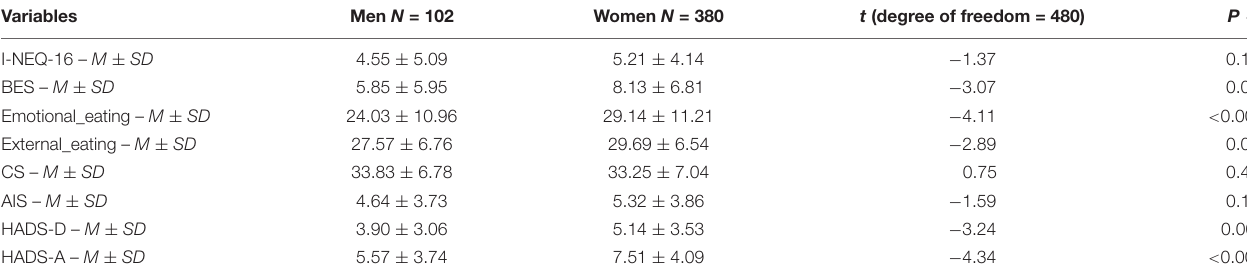
TABLE 3 | Descriptive statistics for all the measures administered broken down by sex ( n = 482). Variables